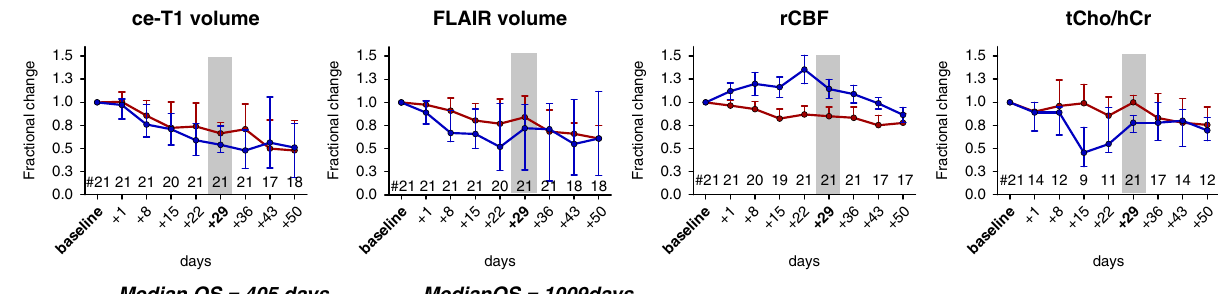
Fig. 2 Fractional changes of ce-T1 volume, FLAIR volume, rCBF, and tCho/hCr ratio in GBM patients treated with cediranib in combination with standard chemoradiation. Median time courses in short and long OS patients are shown, and vertical bars represent standard error of measurement (s.e.m.)